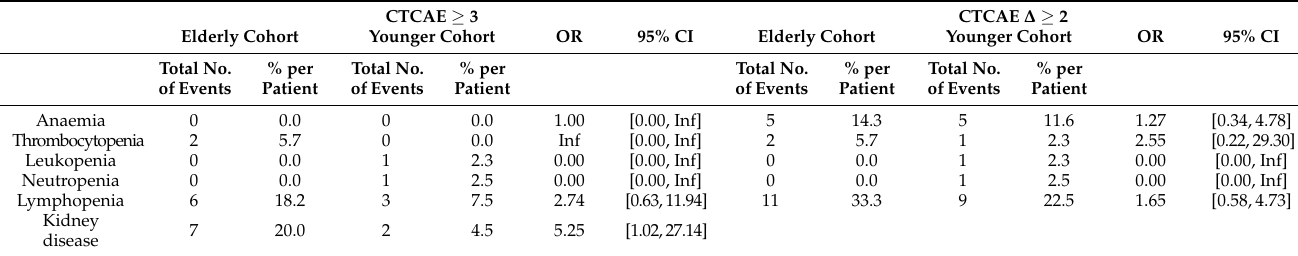
Table 5. Estimated odds ratios of older vs. younger patients for long-term adverse events *, obtained by complete-case analyses, with confidence intervals for the non-inferiority of older vs. younger patients (with relative non-inferiority margin 1.2).